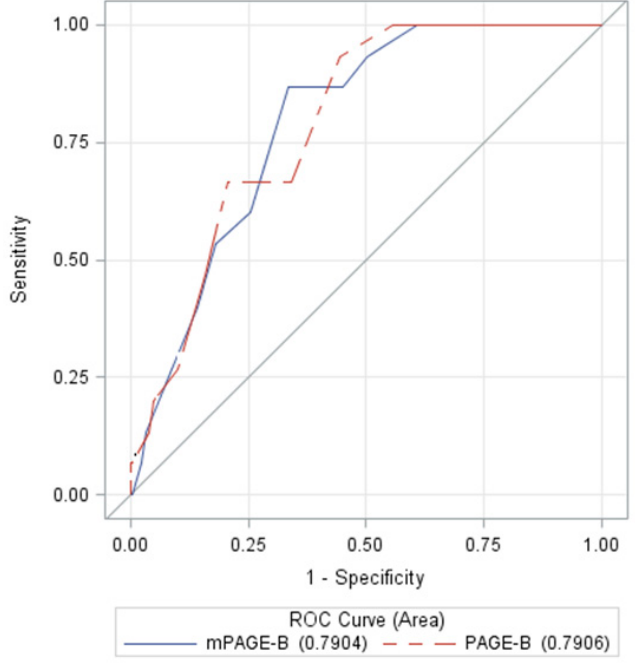
Figure 4. ROC curves of the initial PAGE-B and mPAGE-B scores ( p = 0.9767). ROC: receiver operating characteristic. Table 6. Performance of the initial scores stratified by HBV therapy during